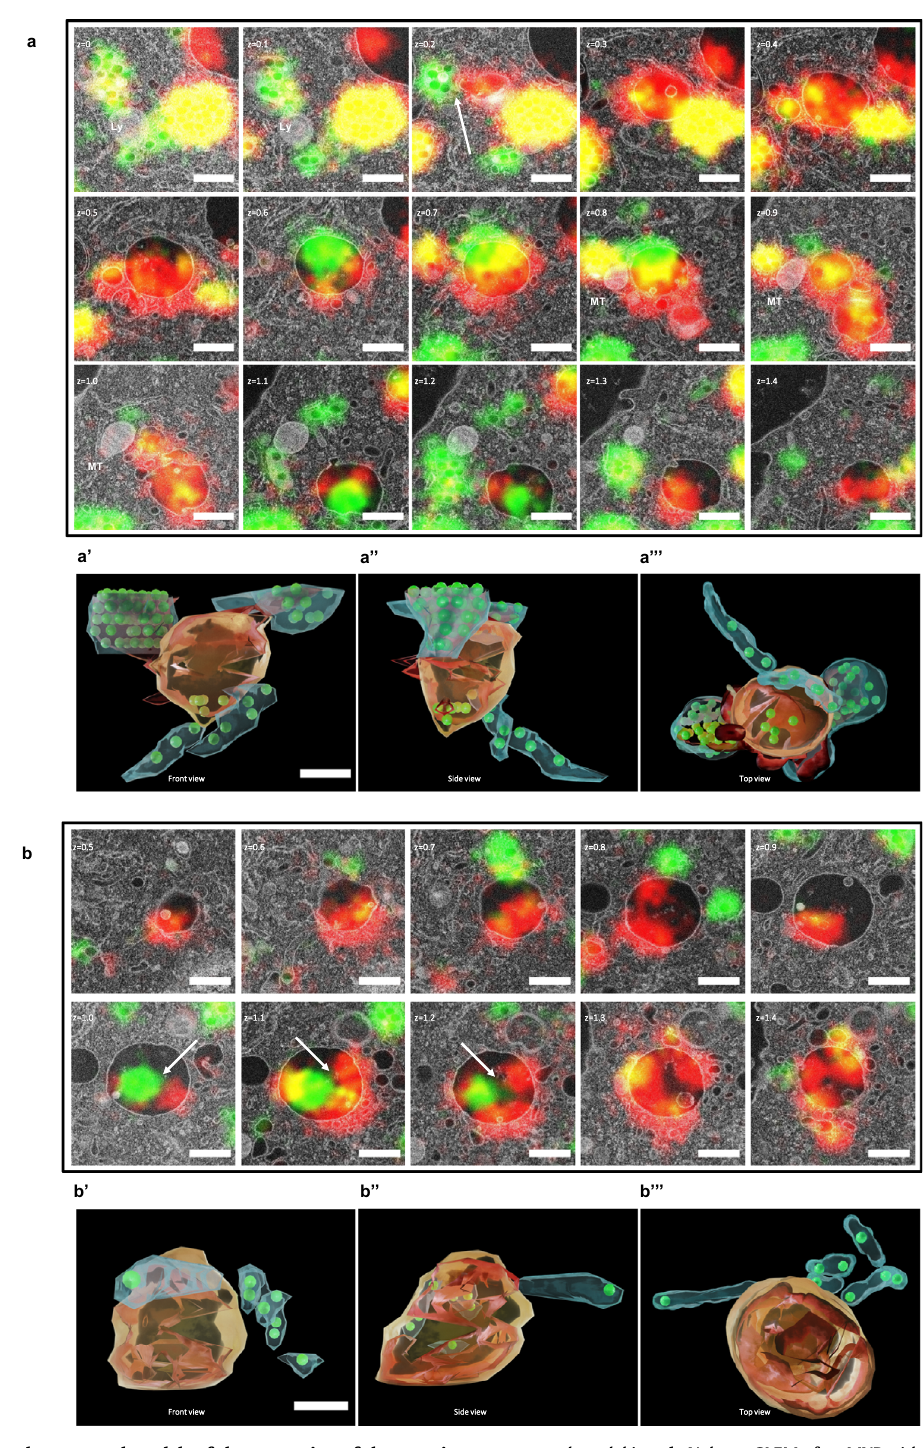
segmented model in a . b . Volume CLEM of an MVB with separated protein corona and PS NPs. b ′ . Front view of segmented model in b . b ″ . Side view of segmented modelin b . b ‴ . Top view of segmentedmodelin b .Red represents the Cy5-labeled protein corona, green represents BODIPY-labeled PS NPs, yellow represents the overlay of the protein corona and PS NPs. Scale bars: